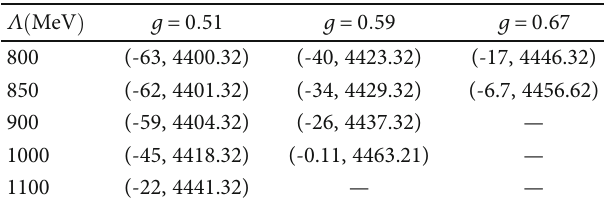
ð MeV ÞÞ for P P c